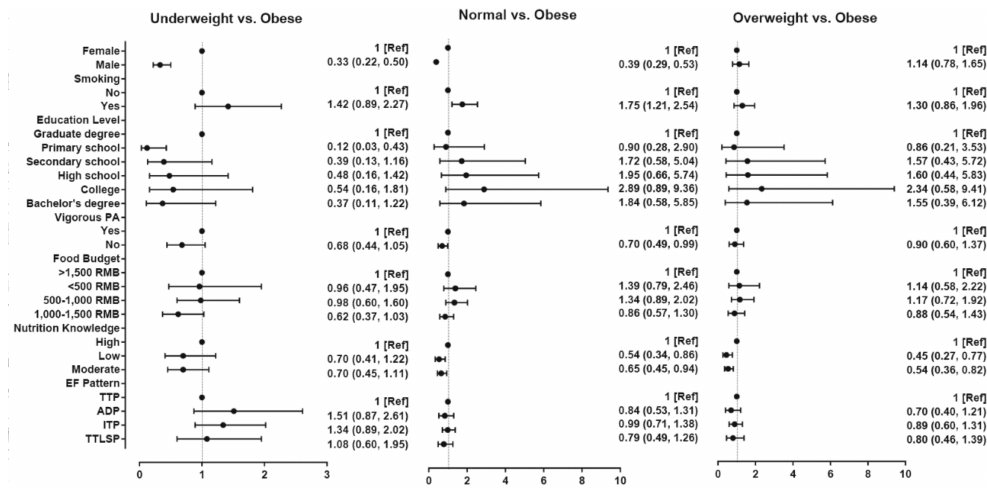
Figure 2. Associations between nutrition knowledge, sociodemographic, and lifestyle factors, EF, and body mass index (BMI)